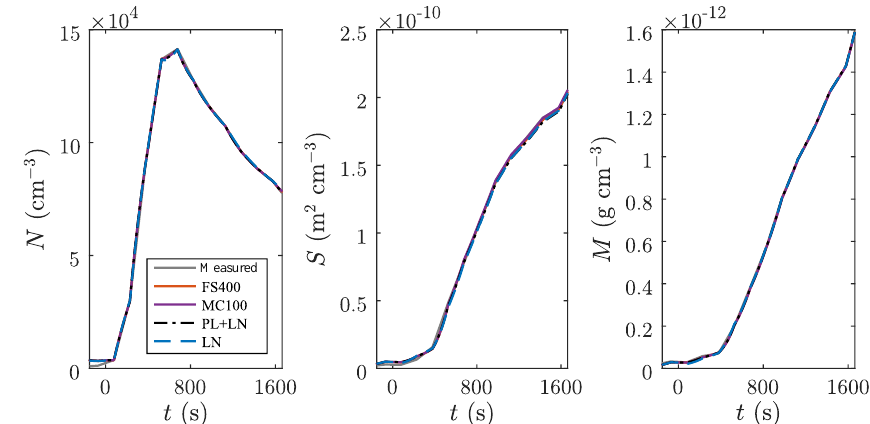
Figure 5. Number ( N ), surface area ( S ), and mass ( M ) concentrations of the nucleation mode in the chamber event. The measured concen- trations and the concentrations produced during inverse modeling using different models are nearly equal. The data are shown for the centers of the Nano-SMPS scans only, because those values only are used in inverse modeling. FS400 denotes the fixed-sectional model with 400 size sections and MC100 denotes the moving-center fixed-sectional model with 100 size